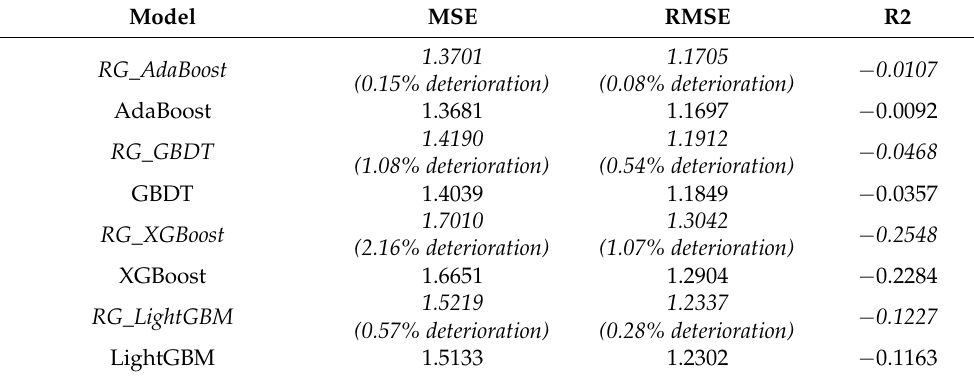
Table 5. The negative effect of the RG hyperparameter optimization on the prediction performance of boosting ensemble learning models when applied on randomly generated uncorrelated data. Model MSE RMSE